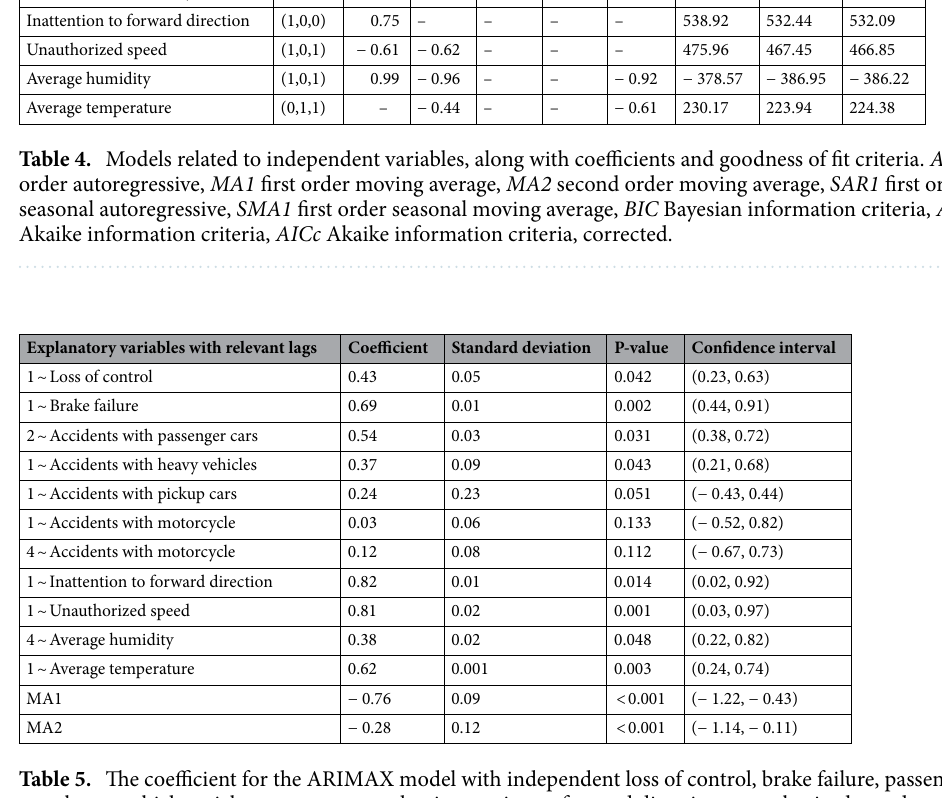
Table 5. The coefficient for the ARIMAX model with independent loss of control, brake failure, passenger cars, heavy vehicles, pickup cars, motorcycles, inattention to forward direction, unauthorized speed, average humidity, and average temperature variables. ~ : Shows influential Lags of explanatory variables on the response.